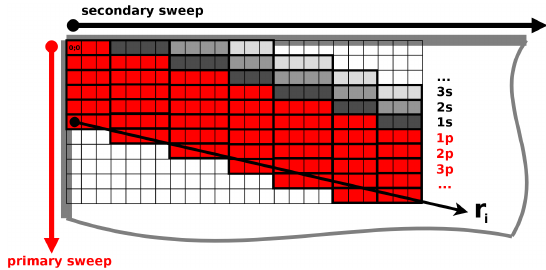
Figure 4. Truncation and shifted start of paths of shape r i during the secondary sweep (shades of gray) ensure the alignment to paths of the primary sweep (red) and second pass